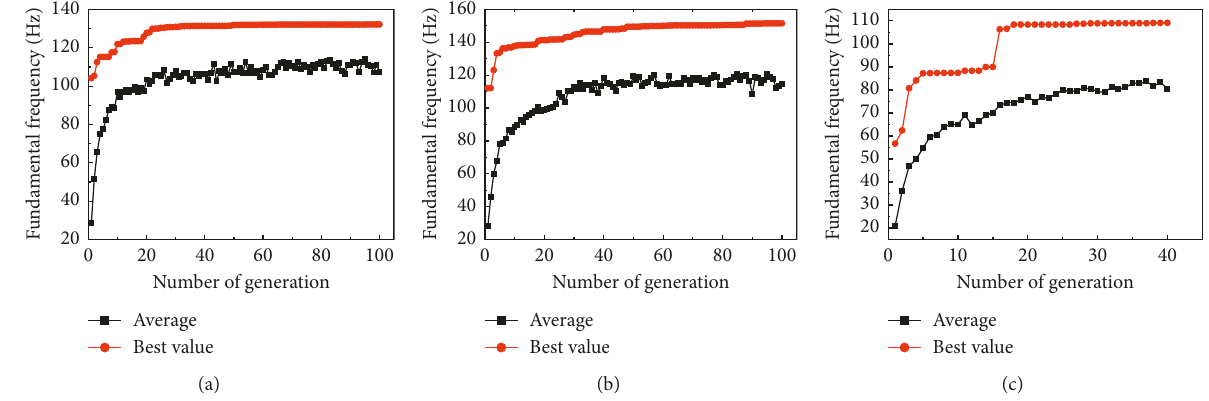
Figure 8: MIGA evolution of shape optimization for Shell 1 with different initial lay-ups. (a) Initial lay-up [45 ° / − 45 ° [0 ° /90 ° 2 /0 ° ] 2s . (c) Initial lay-up [0 ° ] 8s .